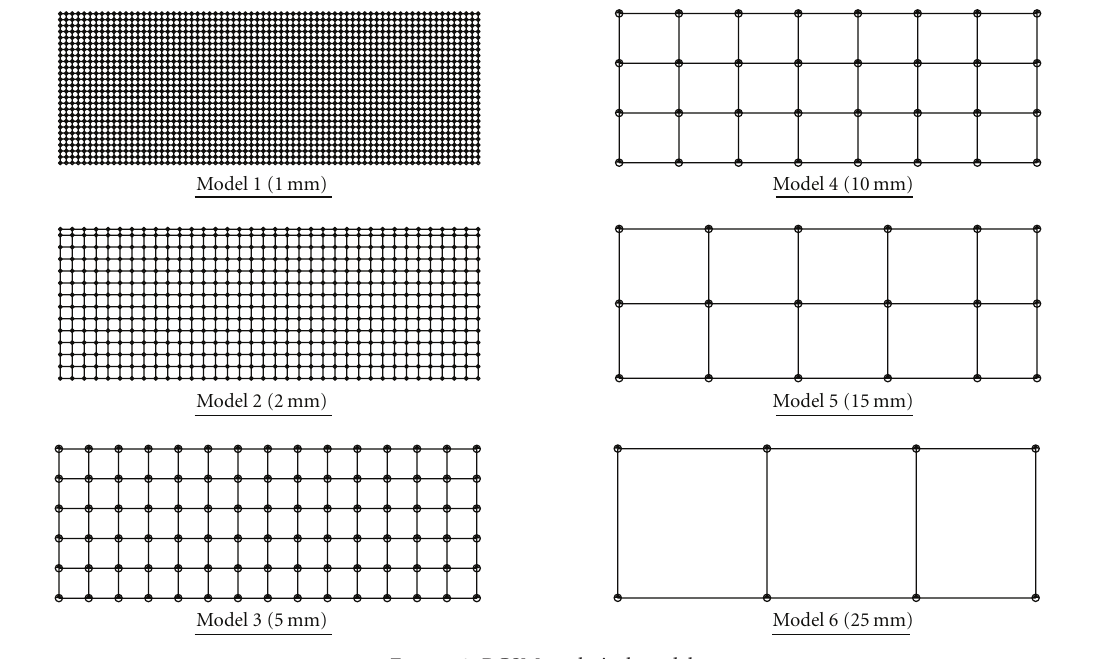
Figure 9: RCSM analytical models.